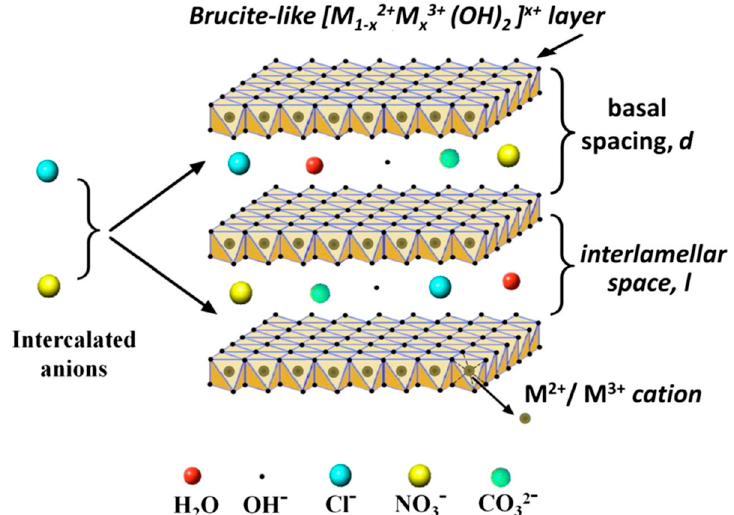
Figure 1. Schematic view of the M 2 + M 3 + LDH general structure, with Cl − , NO 3 − and CO 32 − anions intercalated in the brucite-like structure. Other possible chemical species eventually present in the interlamellar space are reported, i.e., hydroxyl groups and interlayer water molecules. The figure is reprinted from Ref. [24] under a Creative Commons Attribution Non-Commercial No Derivatives License (CC BY ‐ NC ‐ ND).